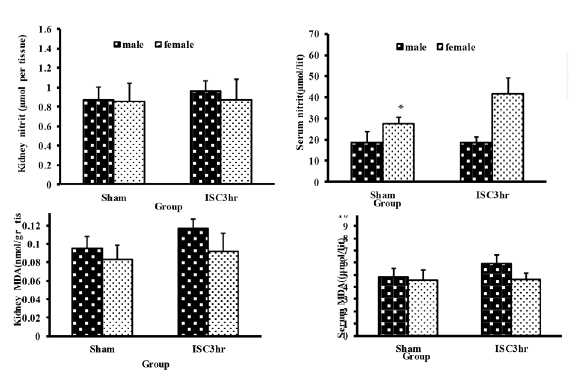
Figure 2. Comparison of Serum and Kidney MDA and Nitrite Levels in Both Male and Female Groups During Ischemia-reperfusion. * indicates significant difference ( P < 0.05) between the sham and ischemia in female rats. The data were reported as mean ± SEM. P values were derived from one-way ANOVA.